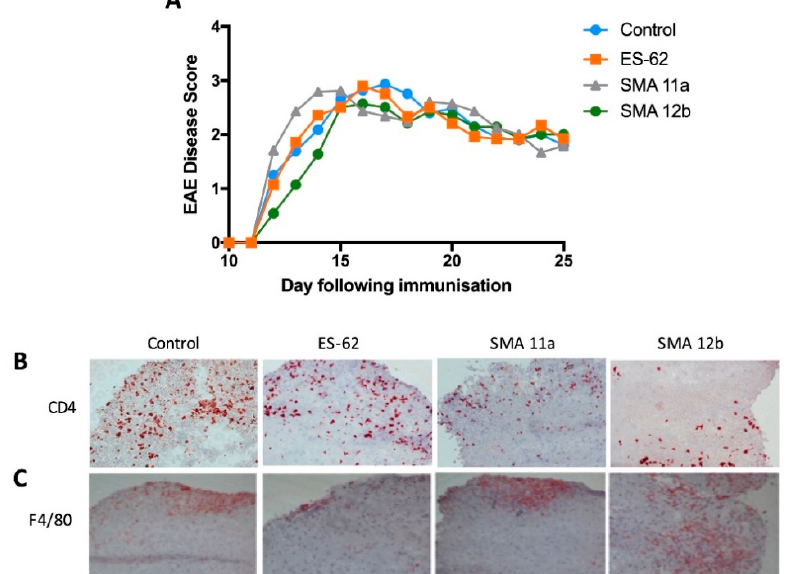
Figure 5. ES-62 and SMAs 11a and 12b do not prevent experimental autoimmune encephalomyelitis. ( A ) Age 7–9 week-old mixed sex C57BL/6 mice were immunised with MOG 35–55 peptide and treated with PBS (control), ES-62, or SMAs 11a or 12b and clinical disease scores were monitored twice daily ( n = 5–7). There were no statistically significant differences amongst groups, and hence, SD values have been omitted to ensure the clarity of the figure. Spinal cords were collected from treatment groups and immunohistochemical analysis of CD4 ( B ) or F4/80 ( C ) was performed and representative images are shown. Magnification = 20 × .